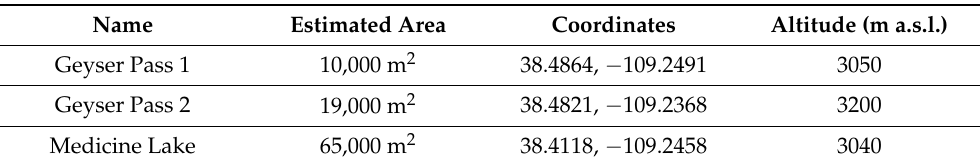
Table 1. The three lichen-draped conifer sites identified in the La Sal Mountains, a sky island on the Colorado